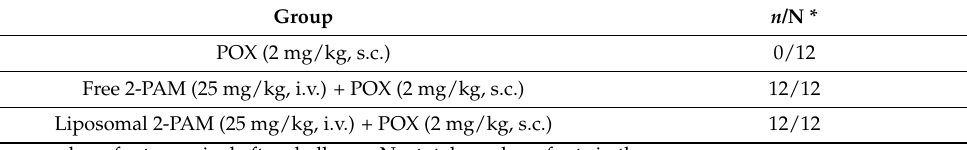
Table 6. Quantitative analyses of Fluoro-Jade B labeling in the dentate gyrus, the CA1 and CA3 zones of the hippocampus, and in the entorhinal cortex of mice poisoned by POX and treated with free 2-PAM or liposomal